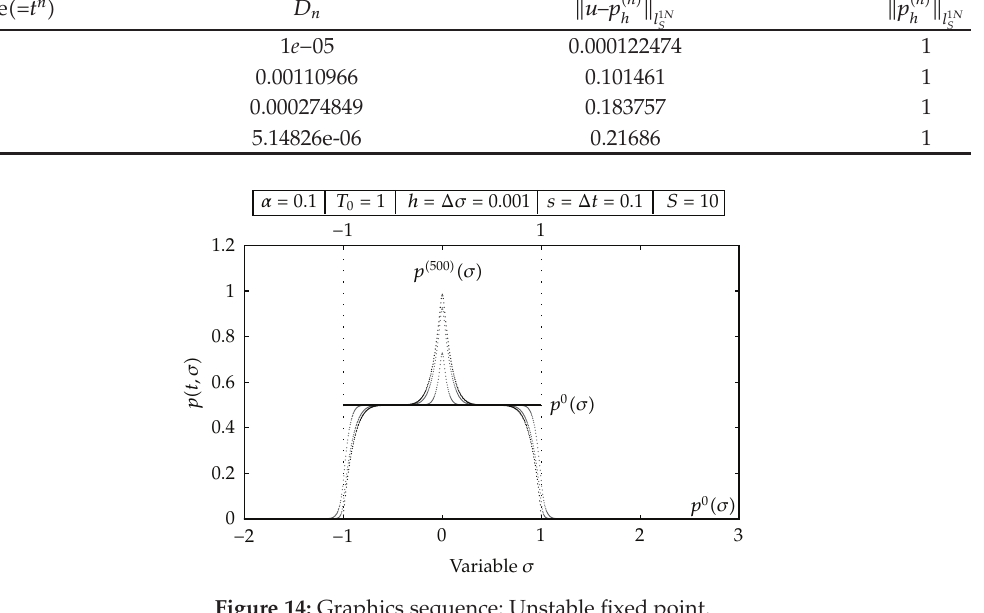
Figure 14: Graphics sequence: Unstable fixed